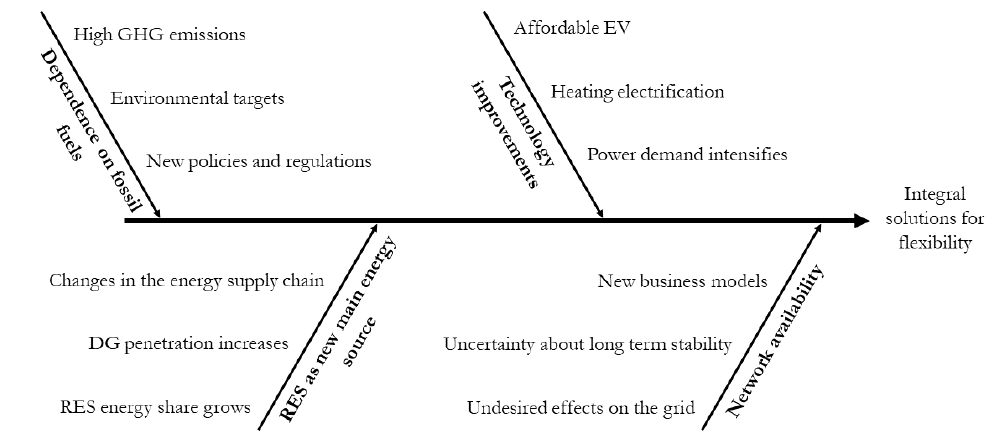
Figure 2. Causes and effects of the transition to RESs, resulting in the need for integral